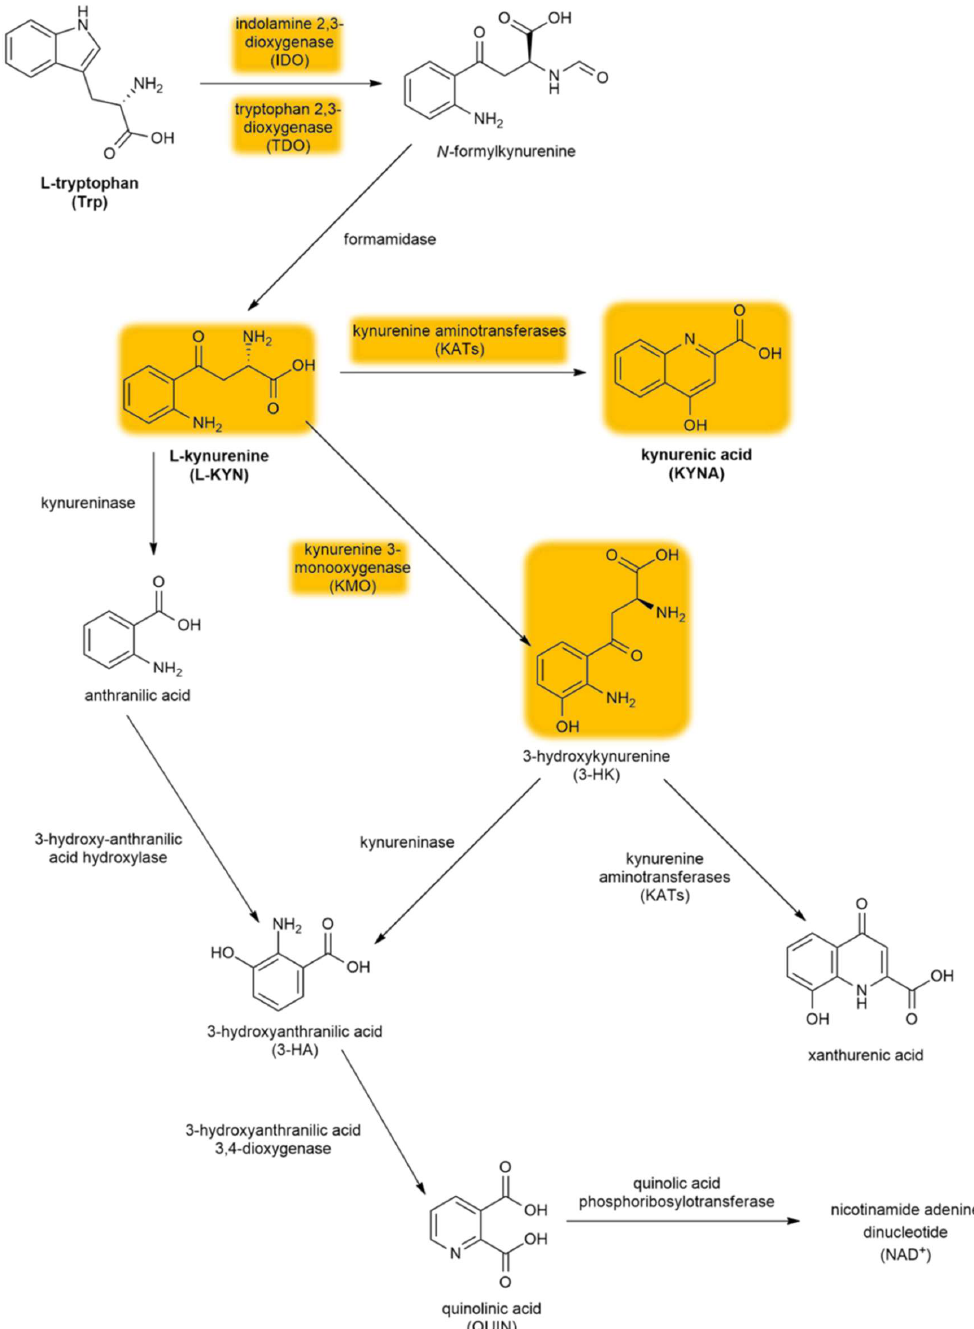
Figure 2. The kynurenine pathway. The yellow background indicates the metabolites and enzymes relevant to schizophrenia. Abbreviations of metabolites and enzymes frequently used in the text are also indicated.